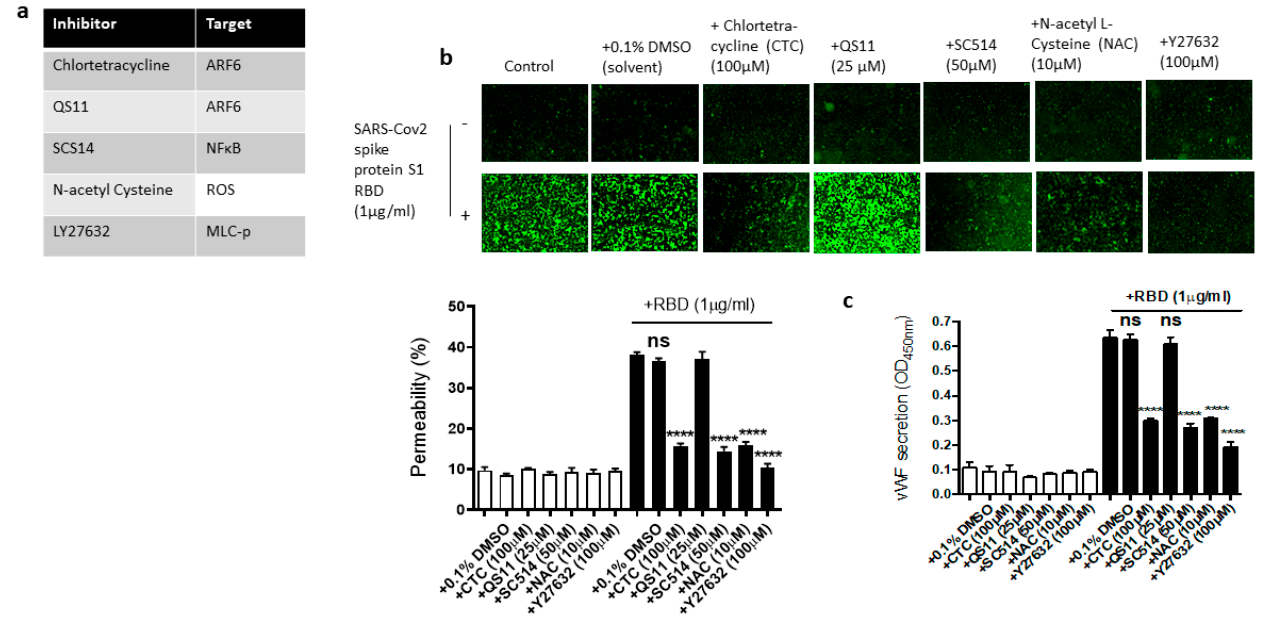
Figure 6. Effect of various inhibitors of ACE2 downstream signaling pathway on the EC permeability and vWF in RBD-stimulated EA.hy 296 cells. The cells pre-incubated for 1–2 h without or with the indicated inhibitor were treated without or with 1 µg/mL of the SARS-CoV-2 spike protein S1 RBD for 72 h. ( a ) The list of inhibitors (and their targets) used in this study. ( b ) Visualization at 10× magnification of the RBD-induced EC permeability inhibition by the indicated inhibitor. ( lower panel ) Represents the quantification data of ( b ). ( c ) Inhibition of the RBD-induced vWF secretion from EA.hy 296 cells by the indicated inhibitor. Statistical significance was measured by one-way ANOVA comparing the RBD-treated group with the control RBD-untreated group (**** p < 0.0001. ns, not significant).